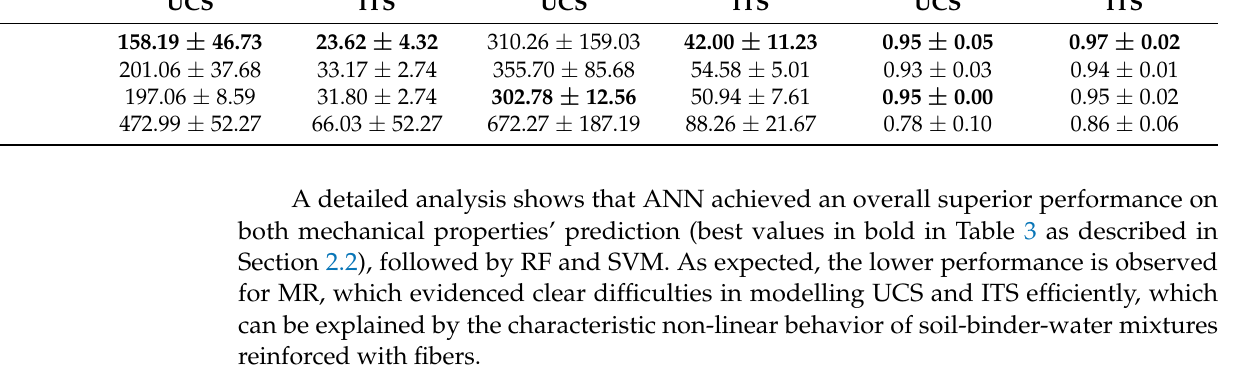
Table 3. A comparison of the models’ performances based on the metrics MAE, RMSE and R 2 (best values in bold).